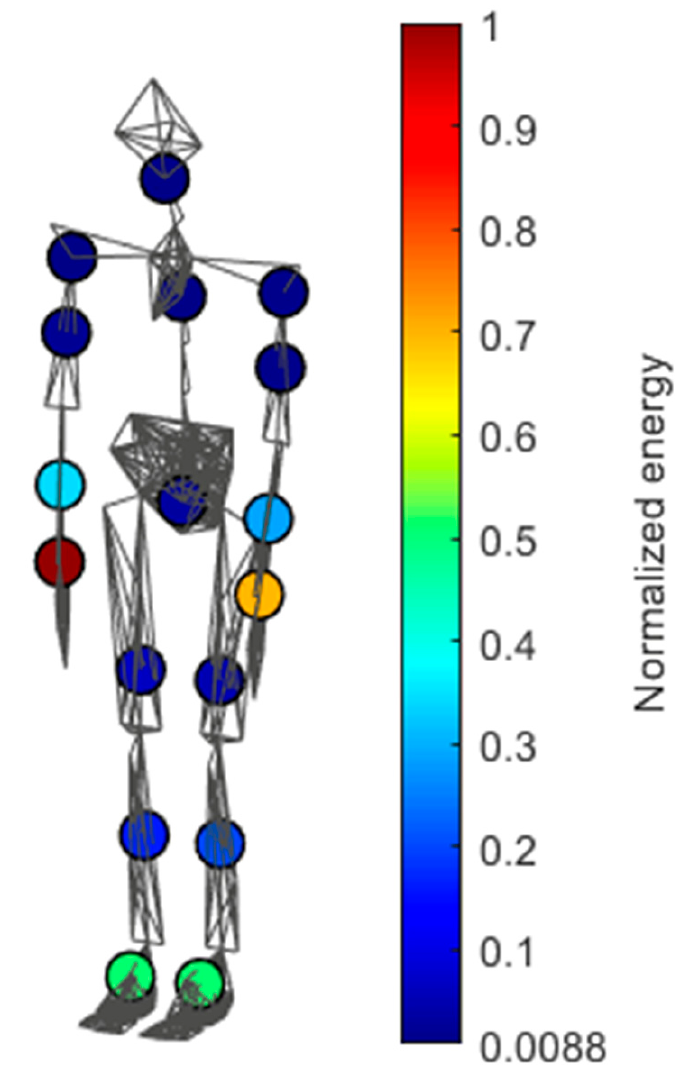
Figure 10. Normalized energy simulation of the different sensor locations, mapped on the biome- chanical model constructed using Xsens. In this case, with a right-handed subject, the best location is the right hand.